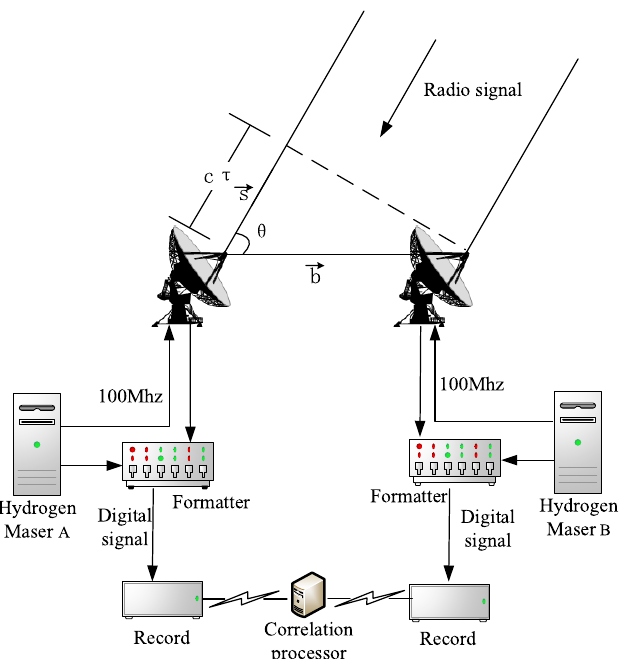
Fig. 1. Measurement principle of VLBI. Here, t is the VLBI time delay, c is the speed of light, source Direction Unit Vector, u is the angle between ~ c t ¼ j b j cos u